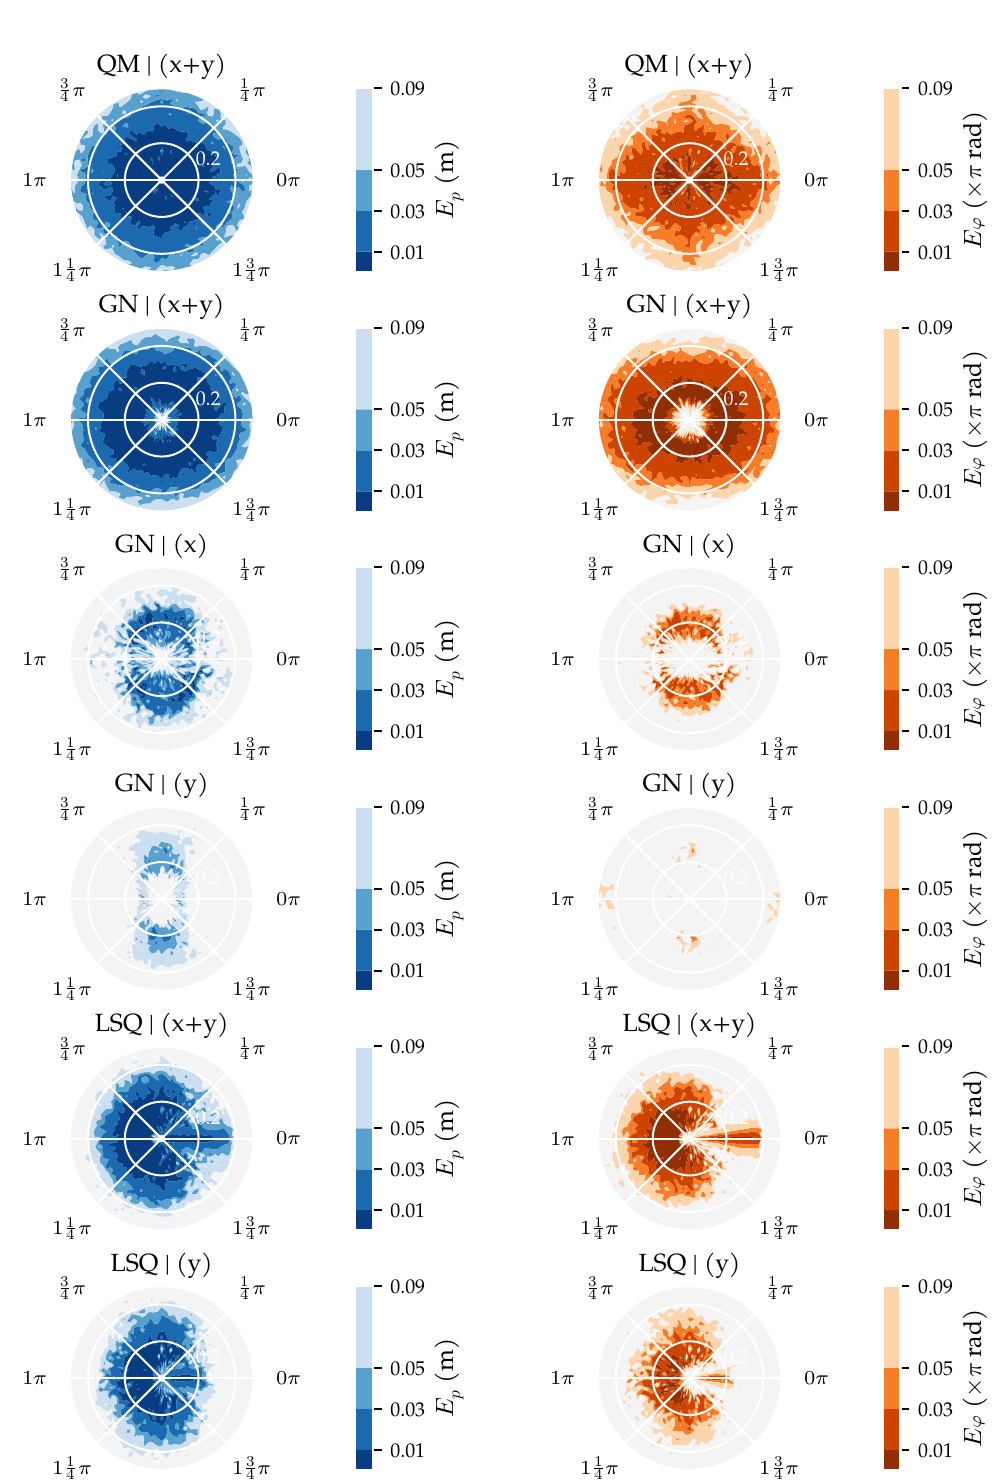
Figure 14. These figures indicate how the movement direction ϕ and distance d of a source state influence the median position error E p (blue) (Equation (4)) and median movement direction error E ϕ (orange) (Equation (5)). The quadrature method (QM), Gauss–Newton (GN), and least square curve fit (LSQ) predictors were used with three sensor configurations: (x + y), (x), (y) at the σ = 1.0 × 10 − 5 ms − 1 noise level. The median errors were computed in cells of 0.01 π rad ×